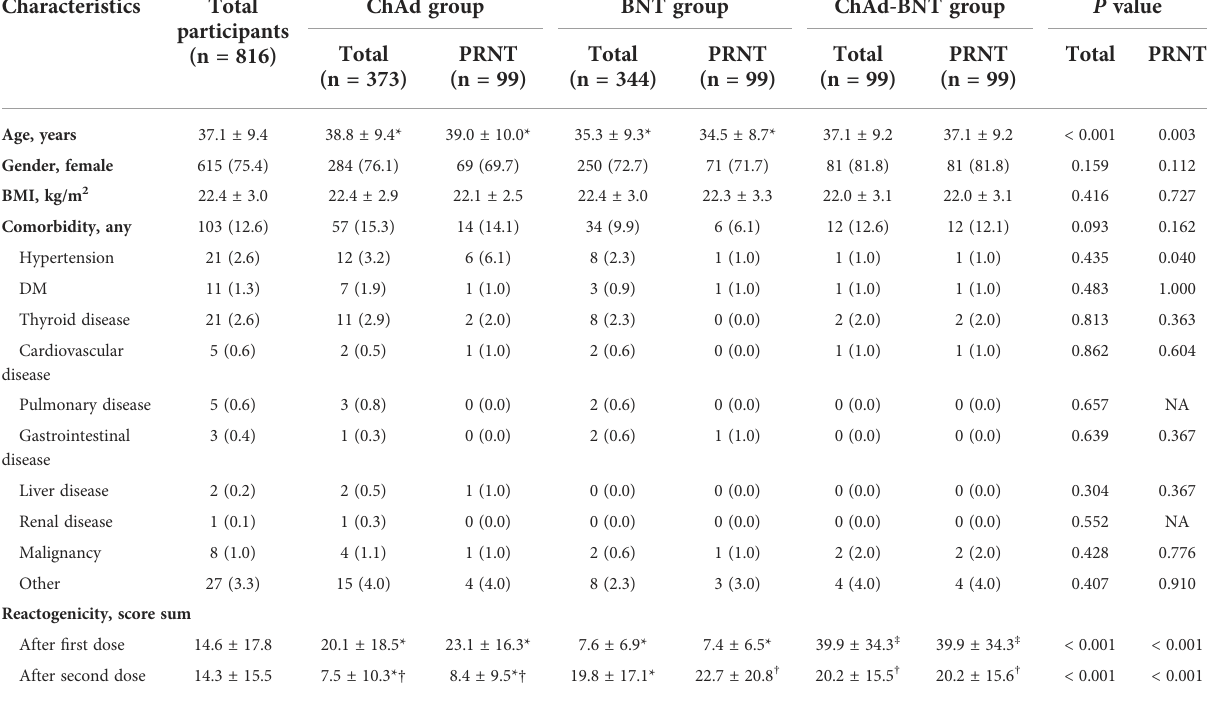
TABLE 1 Baseline characteristics of the study